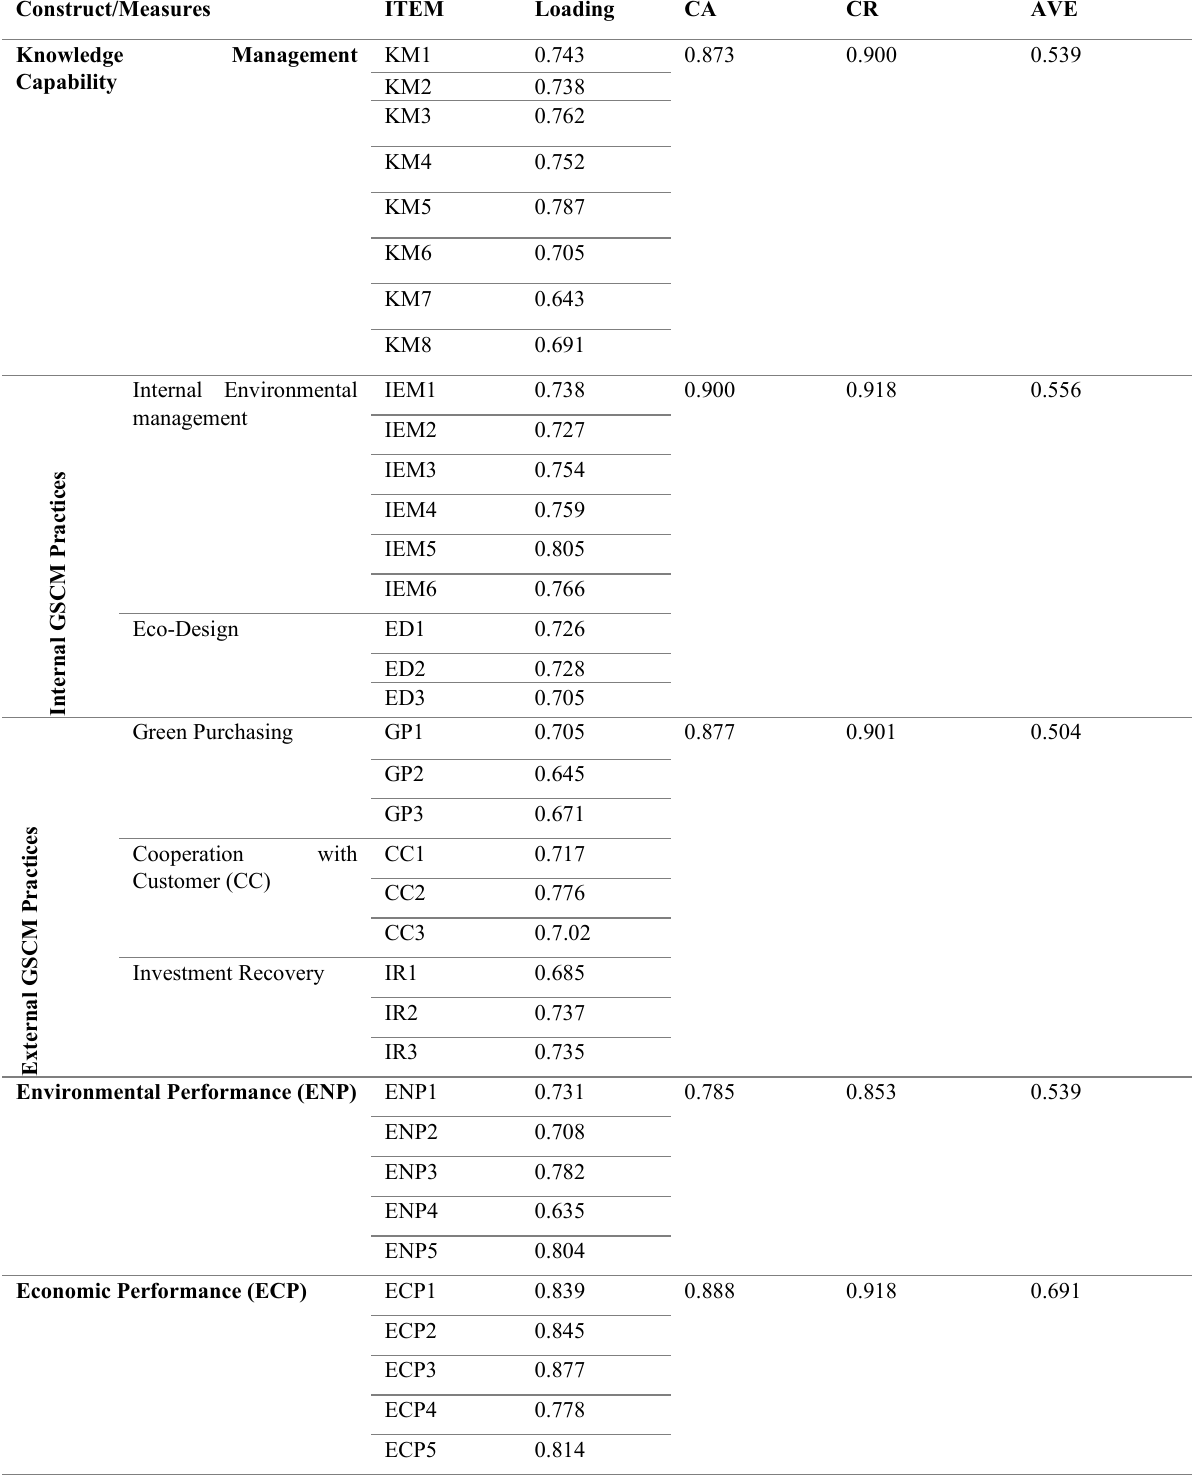
Table 3: Measurement model-quality